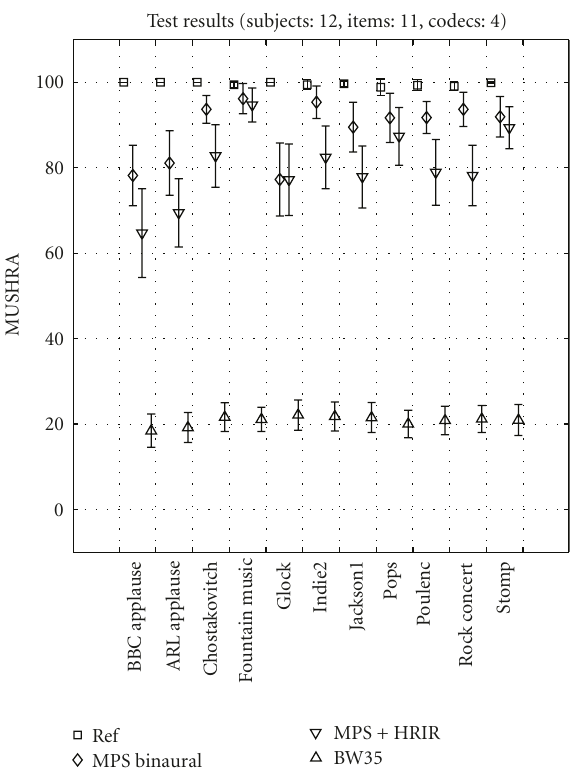
Figure 9: Subjective test results averaged across subjects for the morphed-filter approach. Error bars denote the 95% confidence intervals of the means.